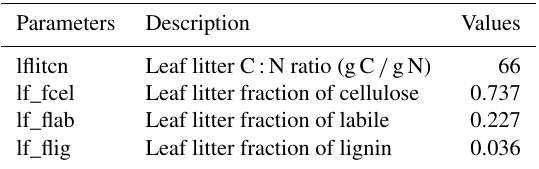
Table 1. Physiological parameters of Sphagnum mosses as given in Hobbie